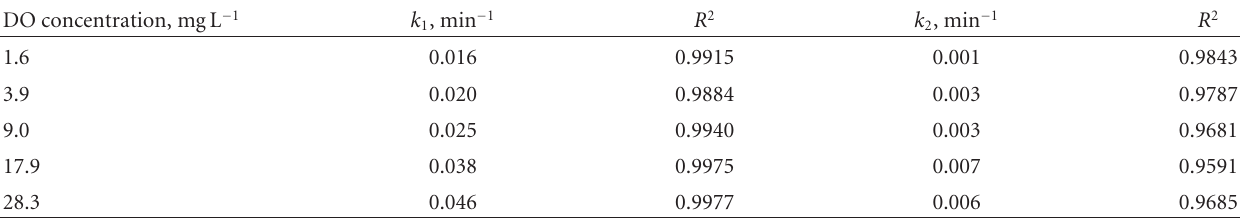
Table 1: Determination of the two-step consecutive kinetic constant for the photocatalytic degradation of MCB at di ff erent DO concen- tration.